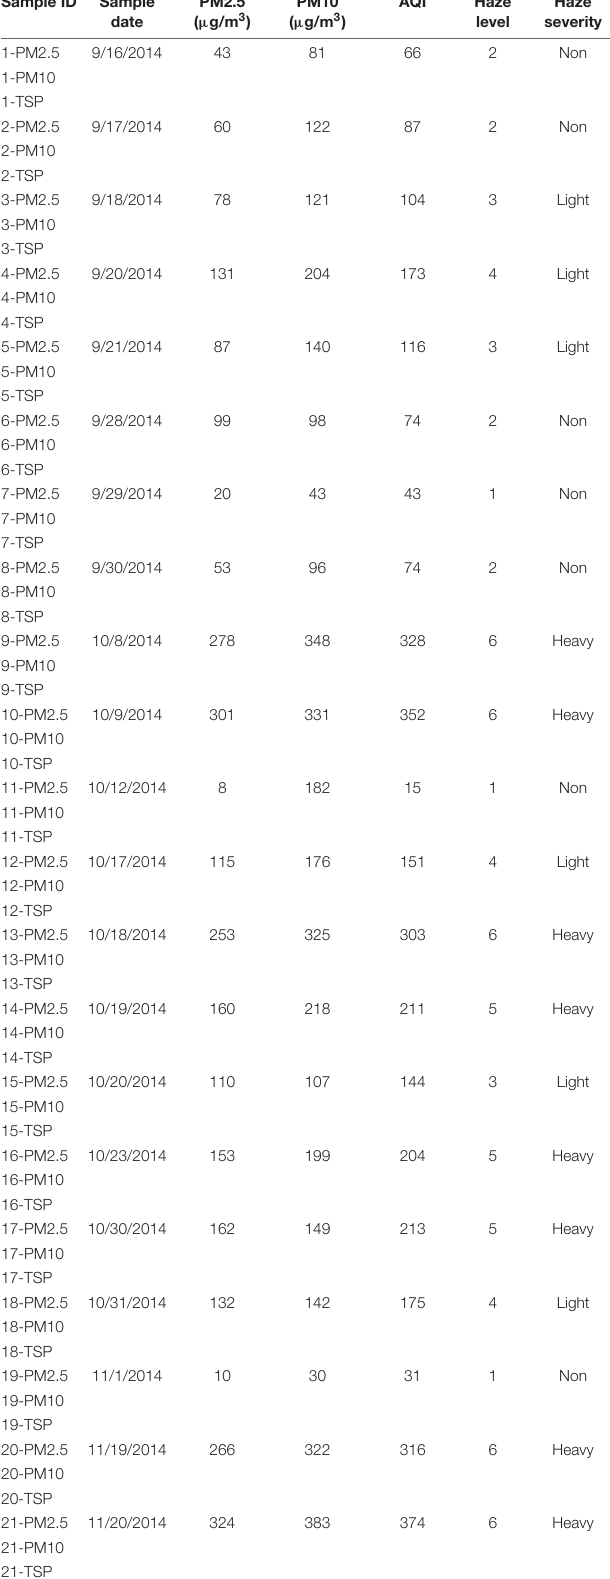
TABLE 1 | Sample information in haze and non-haze